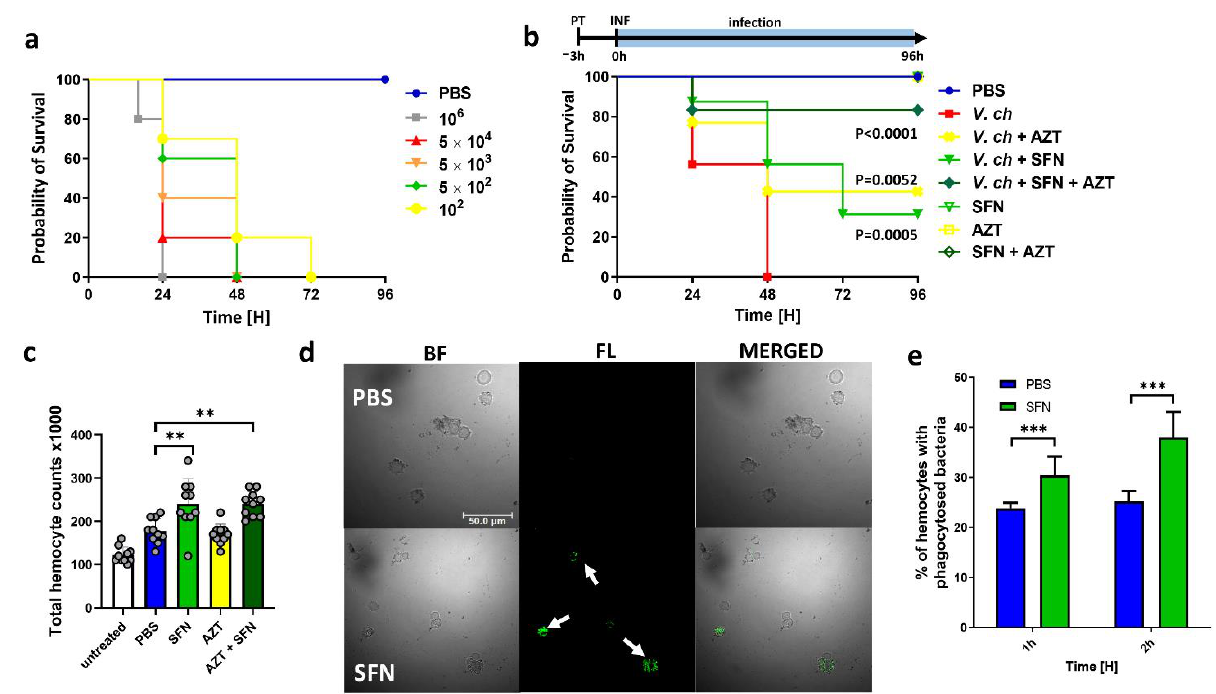
Figure 6. G. mellonella larvae pretreatment with SFN improve their survival rate after V. cholerae infection. ( a ) Kaplan–Meier survival analysis of Galleria mellonella larvae infected with Vibrio cholerae O395. Larvae (n = 15) were injected with (10 µL) PBS (blue circle) or V. cholerae suspension in PBS at range of c.f.u/per dose: 10 2 (yellow circle) or 5 × 10 2 (green deltoid) or 5 × 10 3 (orange triangle) or 5 × 10 4 (red triangle) or 10 6 c.f.u (gray squares). ( b ) Treatment efficacy assessed by survival analysis. Larvae (n = 15) were pre-treated (3 h before infection) with SFN (light green triangle) or AZT (yellow cross) or SFN + AZT (dark green deltoid). Infection groups (filled symbols) were then injected (t = 0 h) with 5 × 10 2 c.f.u of bacterial suspension ( V. ch ), not treated control is represented by red squares. Not infected control groups are marked as empty symbols. Double injection with PBS was performed in the uninfected control group (blue circle). Larvae were injected and monitored as indicated on the timeline above graph. PT- pretreatment INF- infection. ( c ) Total hemocyte infiltration to hemolymph (3 h) in larvae injected with PBS (blue), SFN (light green), AZT (yellow), SFN + AZT (dark green) or not treated (white), individual. ( d ) Representative images of infected hemocytes are shown. The fluorescent signal of FITC-labeled bacteria is indicated by arrows. Scale bar upper left panel denotes 50 μm and applies to the rest of the micrographs. BF-bright light; FL-fluorescence ( e ) Quantification of the phagocytosis percentage. The significance of differences between the results and the control was tested using the Student ’ s t -test. Statistical significance is marked with asterisks: *** p < 0.001; ** p < 0.01.